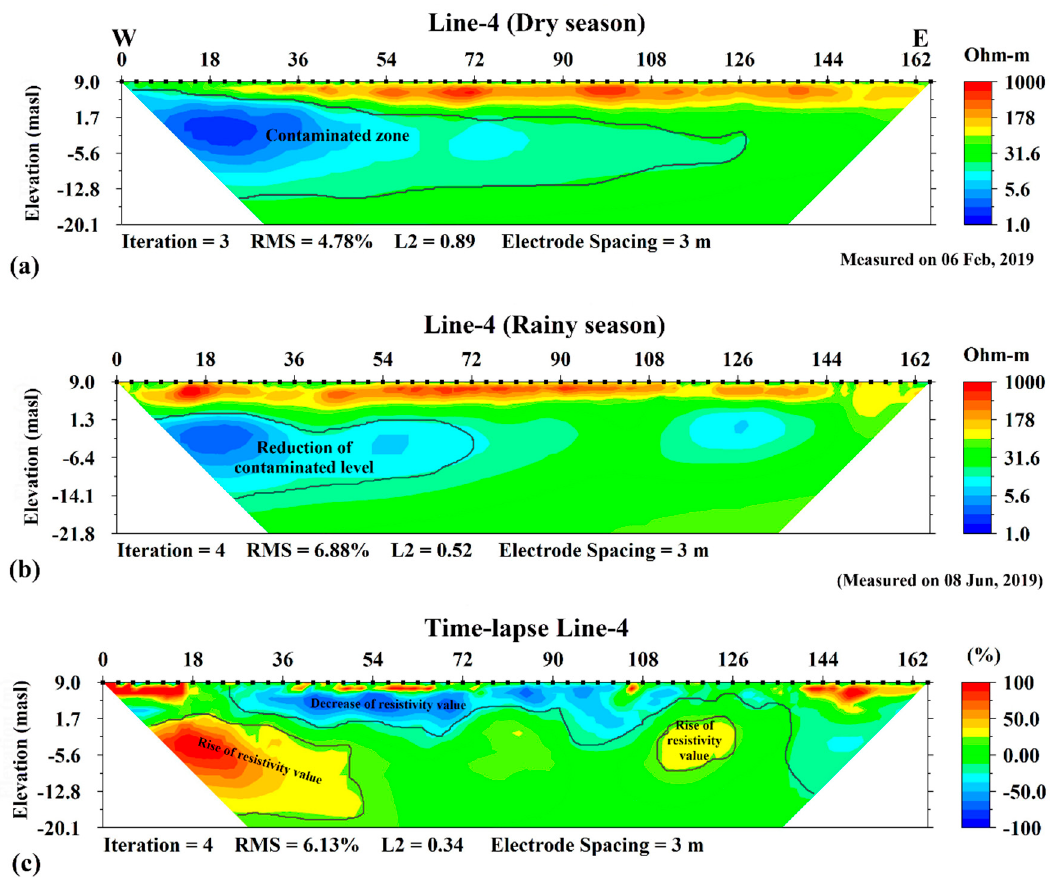
Figure 9. Time-lapse ERI inversion: ( a ) ERI-Line-4 in dry season, ( b ) ERI Line-4 in rainy season, and ( c ) TL-ERI Line-4.